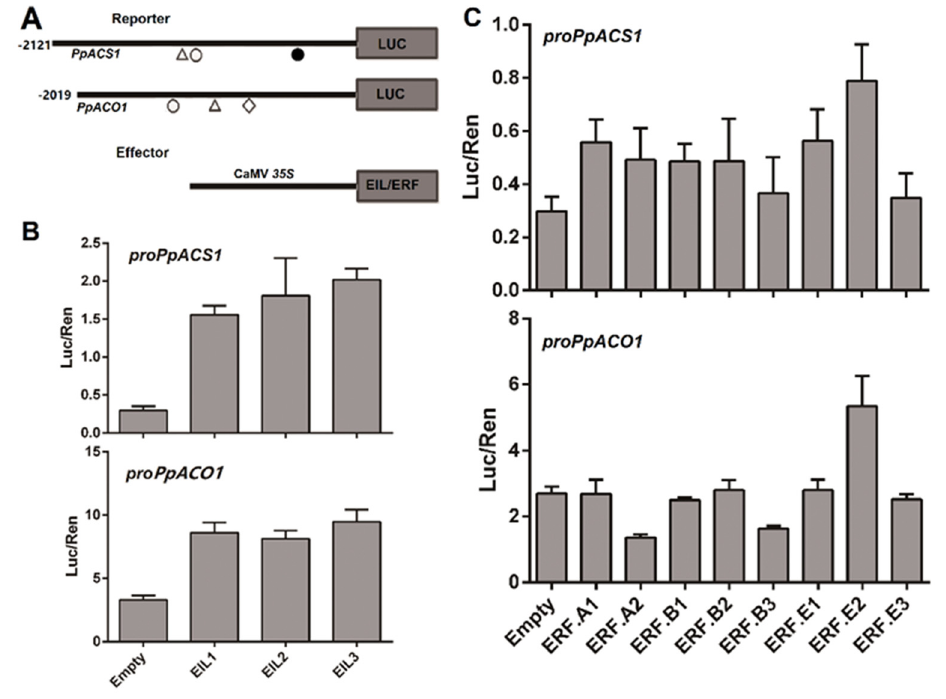
Figure 5. Functional analysis of the promoter sequences of PpACS1 and PpACO1 . ( A ) Construction of the effector and reporter cassettes. Cis -elements were indicated by triangle (DRE motif), black circle (PERE motif), white circle (PERE-like motif), and diamond (GCC-box). ( B , C ) Analysis of the interaction of PpEILs and activator-type PpERFs with the promoters of PpACS1 and PpACO1 using the dual luciferase assay in young leaves of 3- to 4-week-old Nicotiana benthamiana seedlings. The error bars represent SE of four biological replicates.